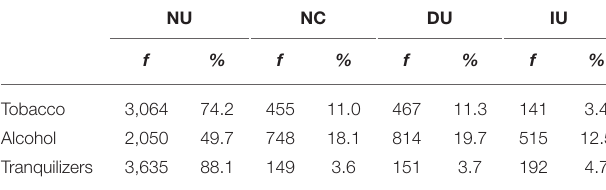
( Table 5 ). Non-users and men reported more positive